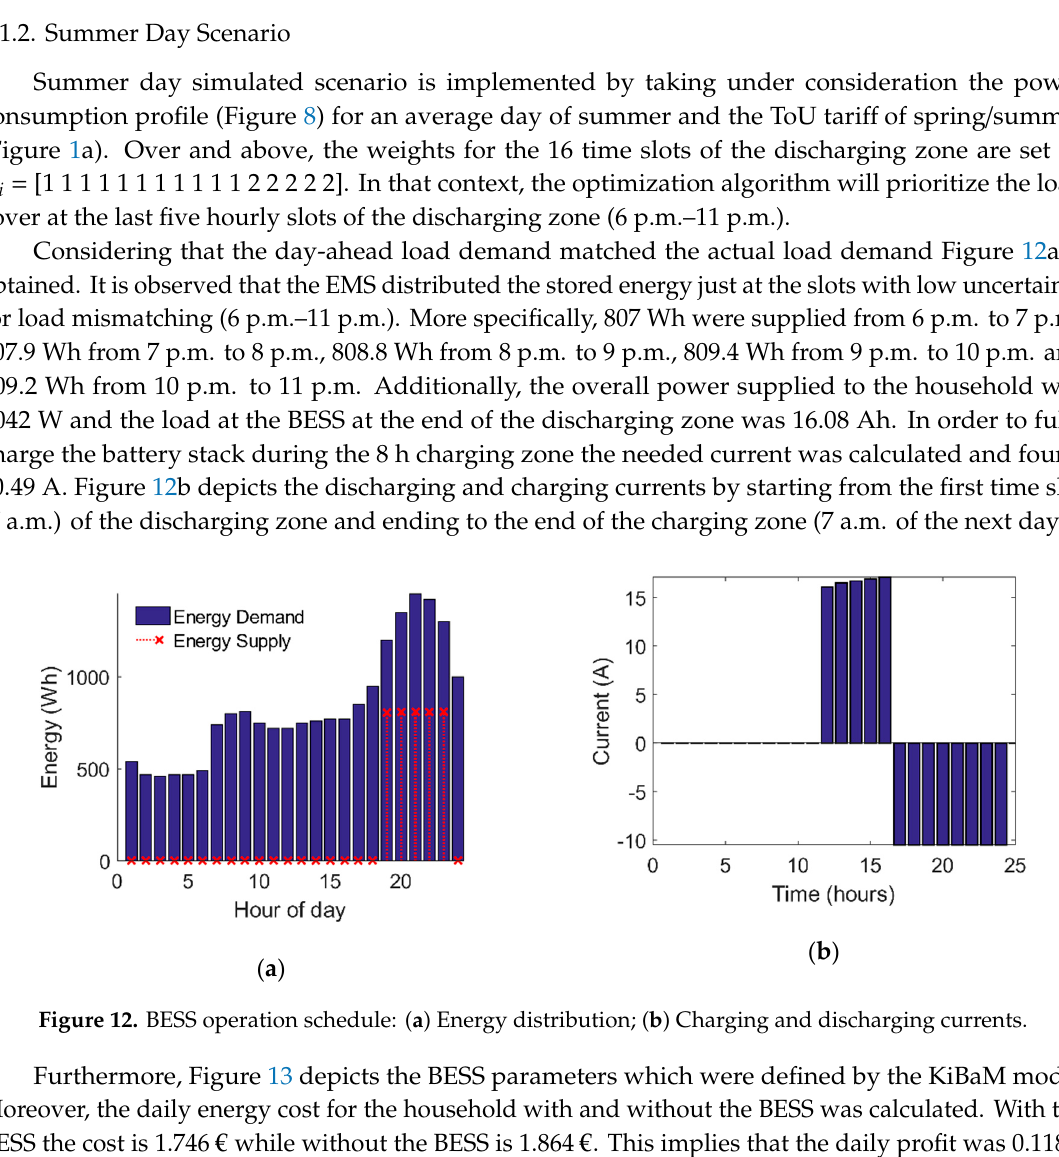
Figure 11. BESS parameters.